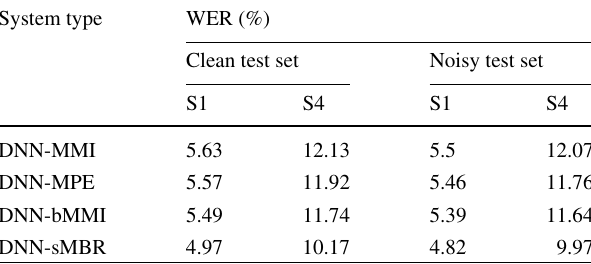
Table 6 WER obtained on varying no of LM models with MPE training criteria in matched and mismatched systems using clean and noisy test sets